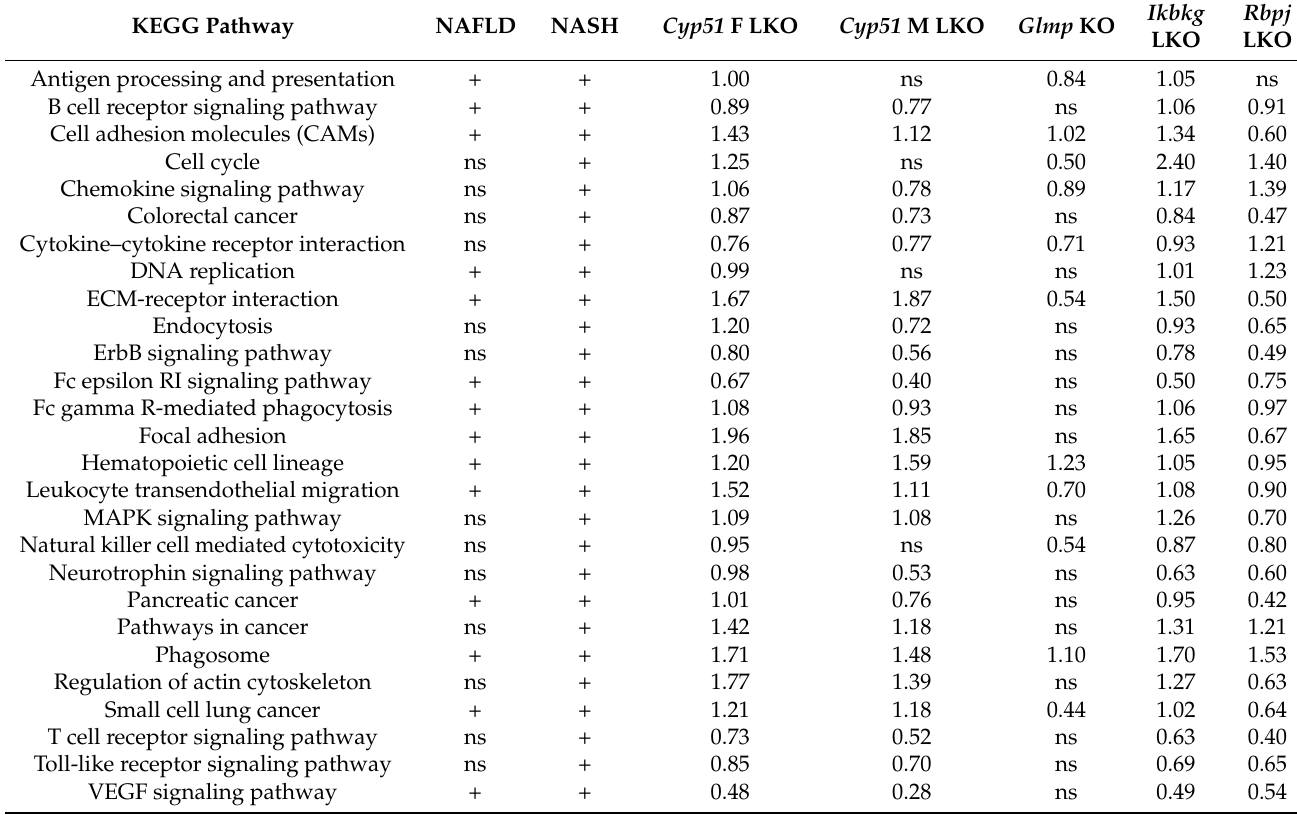
Table 1. Top enriched KEGG pathways common between genetic mouse models of liver fibrosis and human non-alcoholic fatty liver disease (NAFLD) and non-alcoholic steatohepatitis (NASH) from Teufel et al. [18]. KEGG Pathway NAFLD NASH Cyp51 F LKO